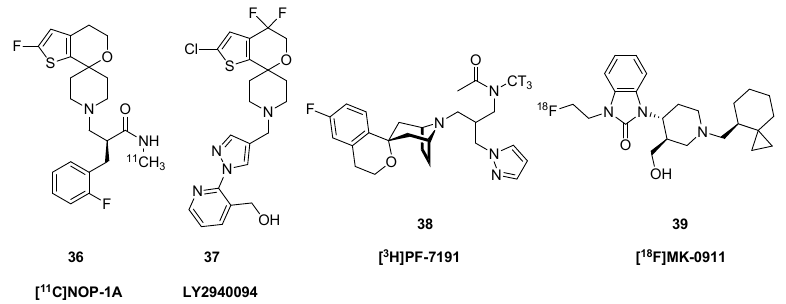
Figure 6. Chemical structures of selected ORL1 receptor